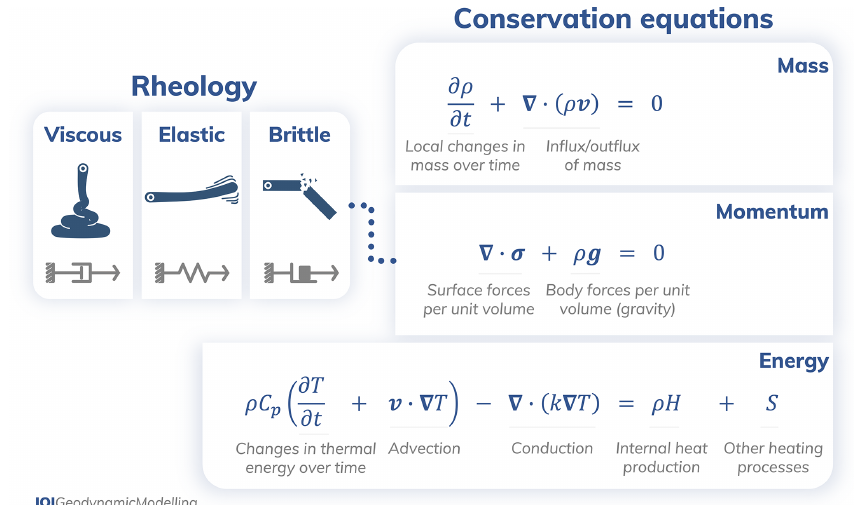
Figure 3. The governing equations: conservation of mass (Eq. 2, Sect. 2.1.1), conservation of momentum (Eq. 5, Sect. 2.1.2), and conser- vation of energy (Eq. 6, Sect. 2.1.3) with different types of rheology (Sect. 2.2.1). In these equations, ρ is the density, t is time, v is the velocity vector, σ is the stress tensor , g is the gravitational acceleration vector, C p is isobaric the heat capacity, T is the temperature, k is the thermal conductivity, H is a volumetric heat production term (e.g. due to radioactive decay), and the term S = S 1 + S 2 + S 3 accounts for viscous dissipation, adiabatic heating, and the release or consumption of latent heat (e.g. associated with phase changes), respectively. Many geodynamic models include additional constitutive and evolution equations. Note that the brittle rheology depicted here is approached by plasticity in geodynamic models, as depicted by the plastic slider in dark grey underneath the breaking bar. See Sect. 2.2.4 for more